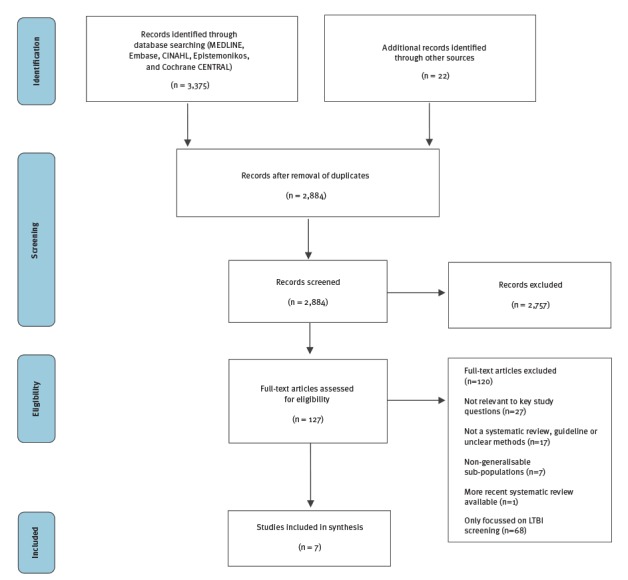
PRISMA flow diagram, literature search for the effectiveness and cost-effectiveness of active tuberculosis screening, 1 January 2005–12 May 2016